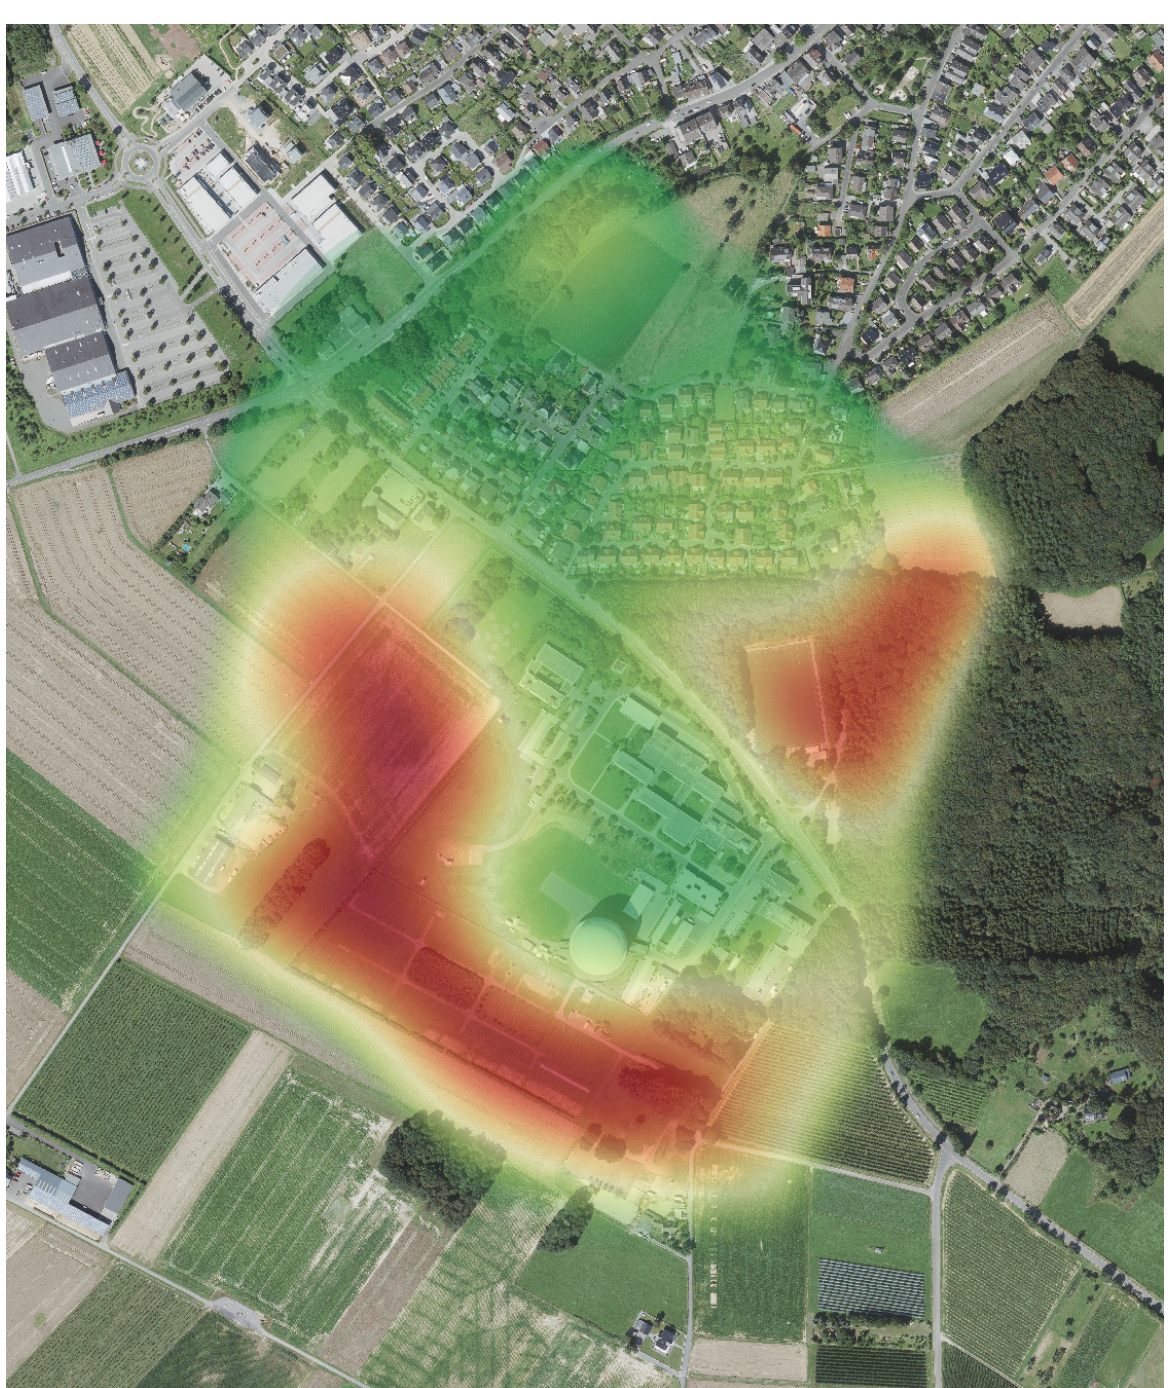
Figure 8. This heatmap visualizes the localization quality over the whole dataset. Green areas correspond to low localization errors, red areas correspond to high localization